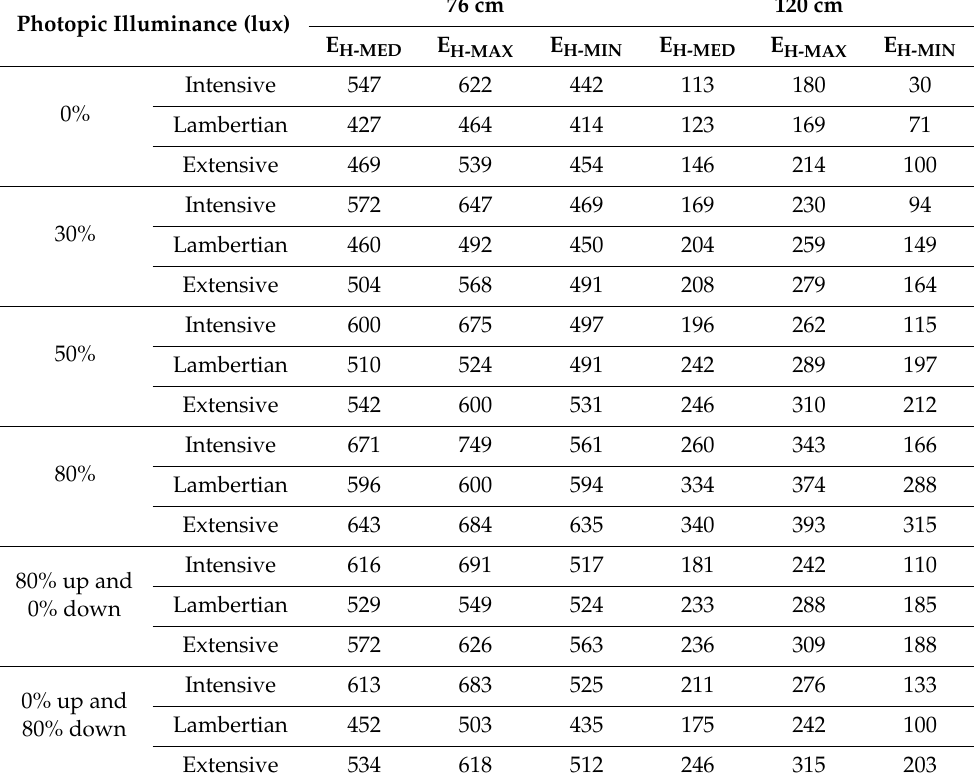
Table 3. Relationship between the horizontal photopic illuminance (lux) in the work plane (76 cm) and the vertical photopic illuminance (lux) in the pupillary plane of the eye (120 cm). The variation in these values with the spatial distribution curves of the luminaires and with the reflectance of the environment is